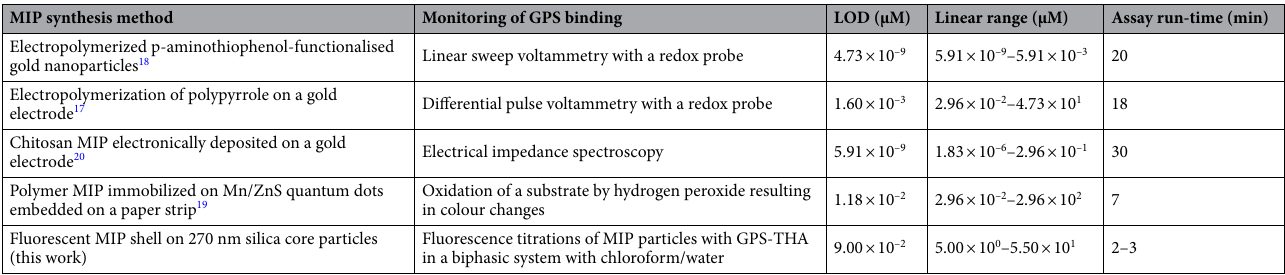
Table 2. Examples of MIP-based sensors for direct detection of GPS in